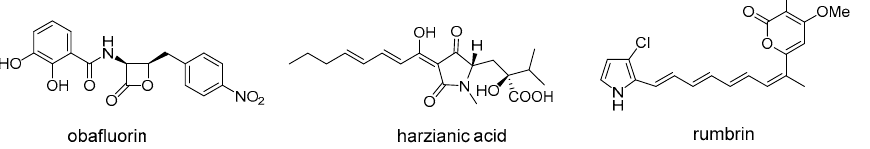
Figure 6. Structures of representative natural products that determine the biomolecular target through antibiotic resistance genes.